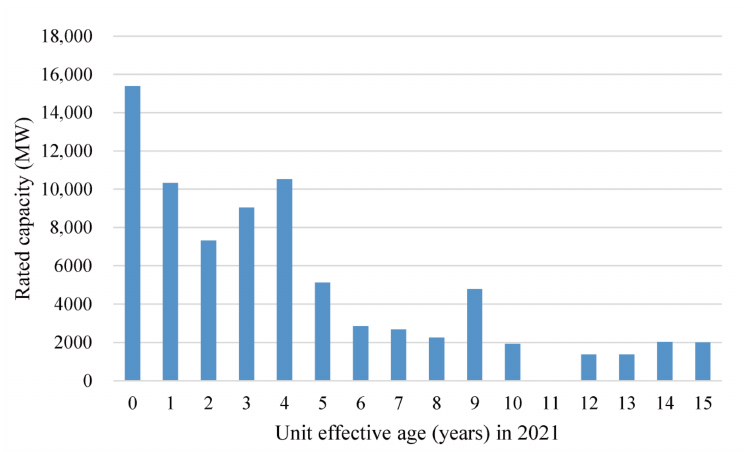
Figure A1. Capacity age-distribution of first-stage coal units (in the year 2021).